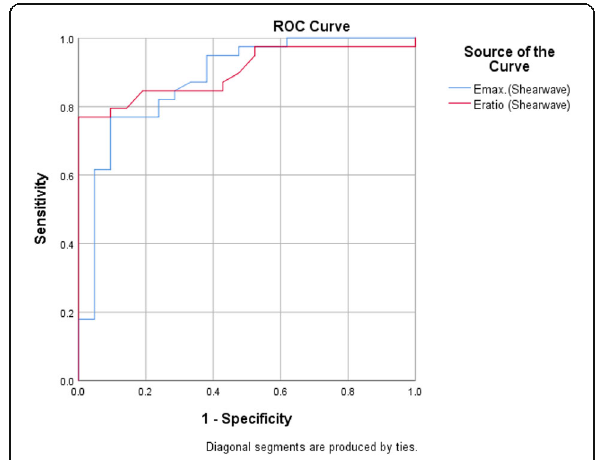
Fig. 3 ROC curve analysis for Emax and Eratio values